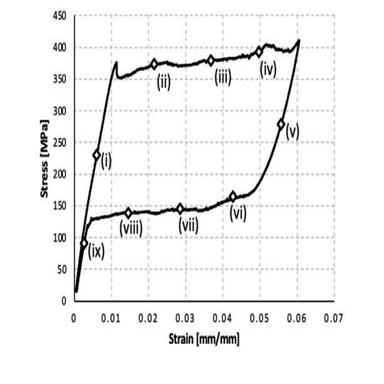
(a) Instants of the cycle (i-ix) where the sequence of specimen deformations in (b) was determined. Horizontal displacements are amplified of 10 times, and the regions occupied by austenite and martensite, obtained from the strain maps, are represented in light and dark grey, respectively. The complete deformation history is available in the Video 1.